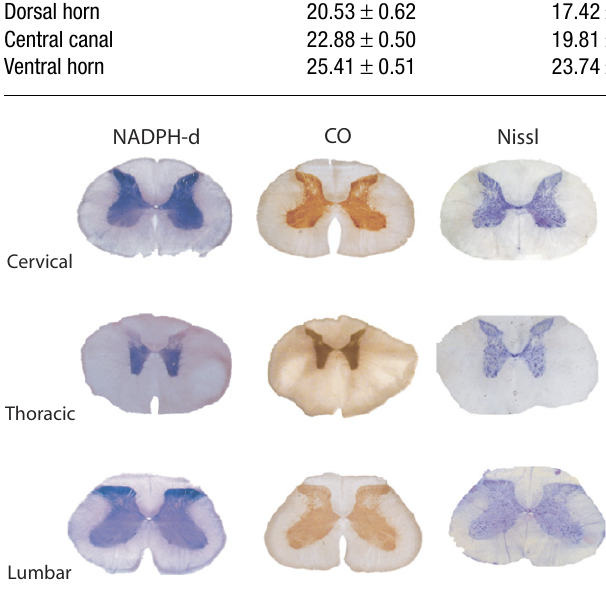
Table 1. Average diameters of NADPH-d type I neurons across spinal cord. Cell bodies of ventral horn neurons are larger than other regions. Segments Regions